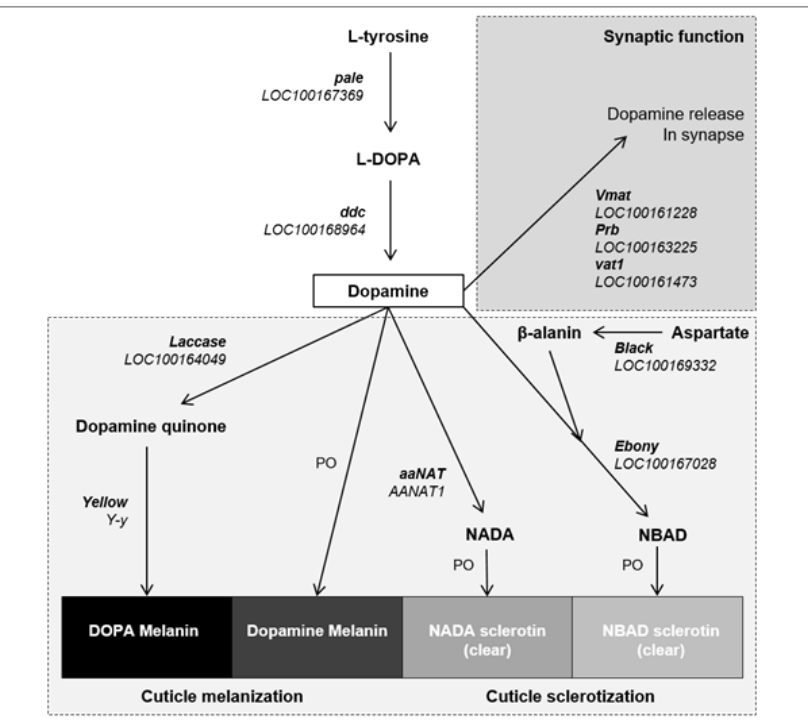
Figure 1 – Dopamine biosynthesis and mode of action pathway. L-tyrosine is first hydroxylised by pale (tyrosine hydroxylase) into L-DOPA which is then subsequently decarboxylised by ddc (dopa-decarboxylase) to produce dopamine. Dopamine can then directly be released within synapses and act as a neurotransmitter. Vesicle amine transporters such as Vmat, prb and vat1 are likely to play a key role in this process. Dopamine can also be used as a structural component of the cuticle: either as DOPA melanin (black cuticle) when processed by laccase and yellow enzymes, or as NADA sclerotin (clear cuticle) through the action of aaNAT enzyme, or as NBAD sclerotin (clear cuticle) when conjugated with β-alanin through the activity of ebony and black (responsible for metabolization of aspartate into β-alanin) enzymes. In bold are indicated the names of the key enzymes functionally characterized in Drosophila; just behind are indicated in italic type the name of the closest pea aphid homologue from the latest release of the pea aphid genome (v2.1). PO: enzymes from the phenoloxidase